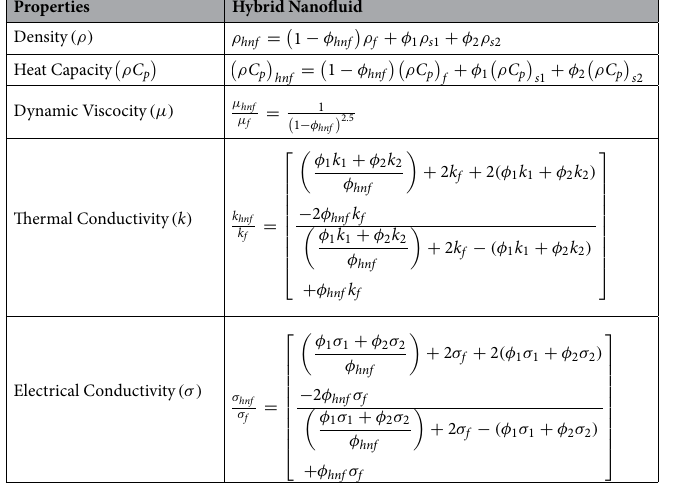
Table 2. Hybrid nanofluid’s correlations 13 .